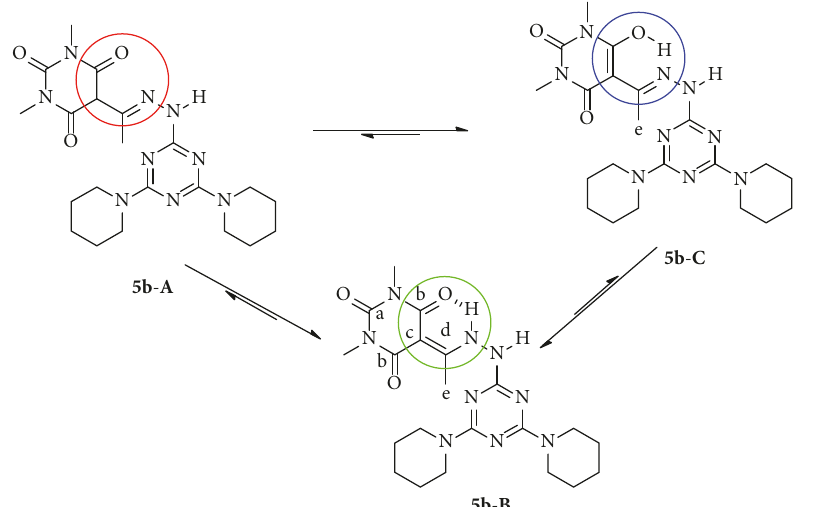
Figure 3: Tautomeric structure of 5b